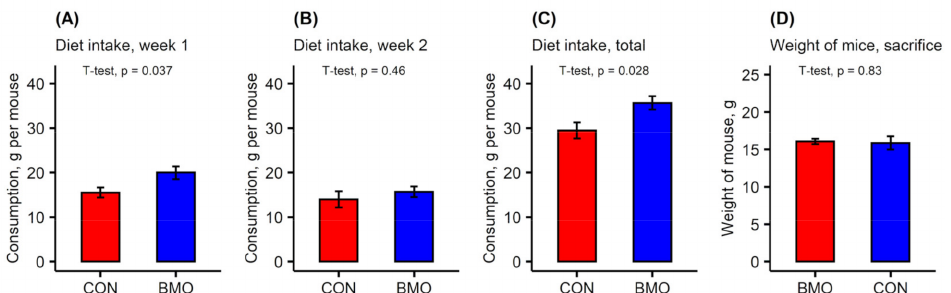
Figure 2. Background data on mice. ( A – C ) Diet consumption during week 1 and 2 and in total over the course of the experimental period was measured per cage and was normalized to the number of animals in individual cages to express g/mouse and ( D ) Body weight of mice at the end of the experimental period (BMO: n = 11, CON: n = 9). Values are means and error bars show standard